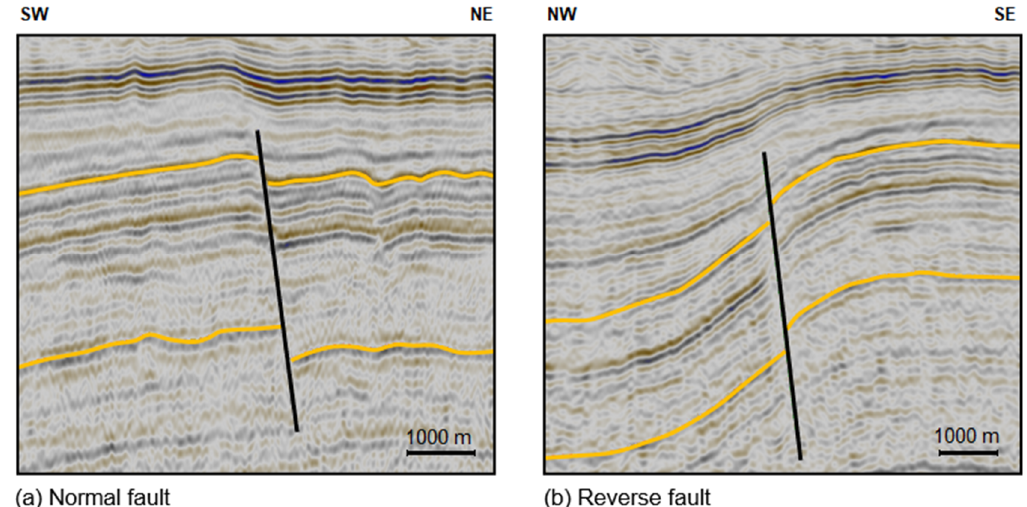
Figure 1. Seismic profile of the examined fault geometries shown by black lines ( a ) normal fault and ( b ) reverse fault. The Miocene-Oligocene interbedded sandstones are illustrated in yellow marked horizons and encased by shales.